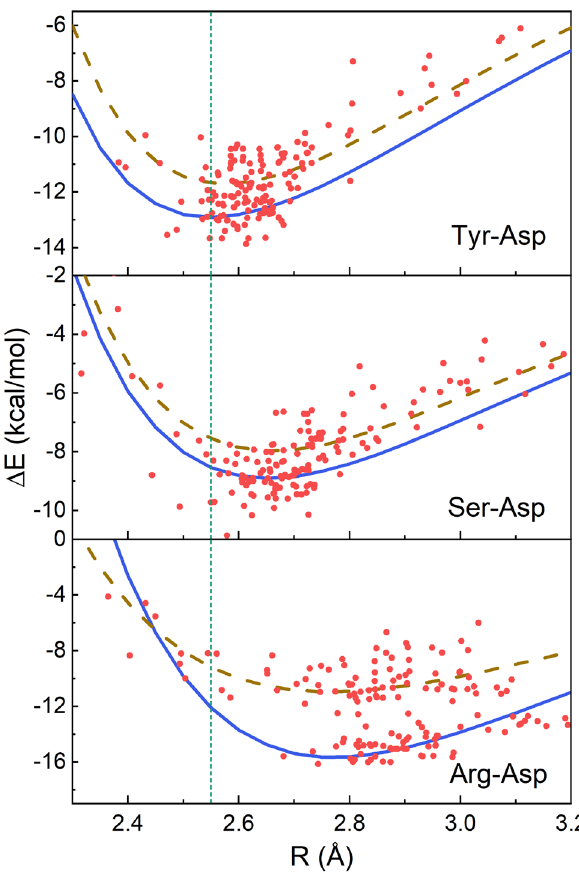
Figure 4. Interaction energies of the Tyr-Asp, Ser-Asp and Arg-Asp side chain-side chain hydrogen bonds. For each type of the hydrogen bond, the red dots represent the interaction energies of 150 randomly chosen configurations. We further calculate how the hydrogen bond energies of the configurations from the first and second maxima of the geometric probability distributions vary with R, which are shown as the solid and dashed lines, respectively, in each plot. The vertical line represents the potential energy minimum of the Tyr-Asp pair at R = 2.55